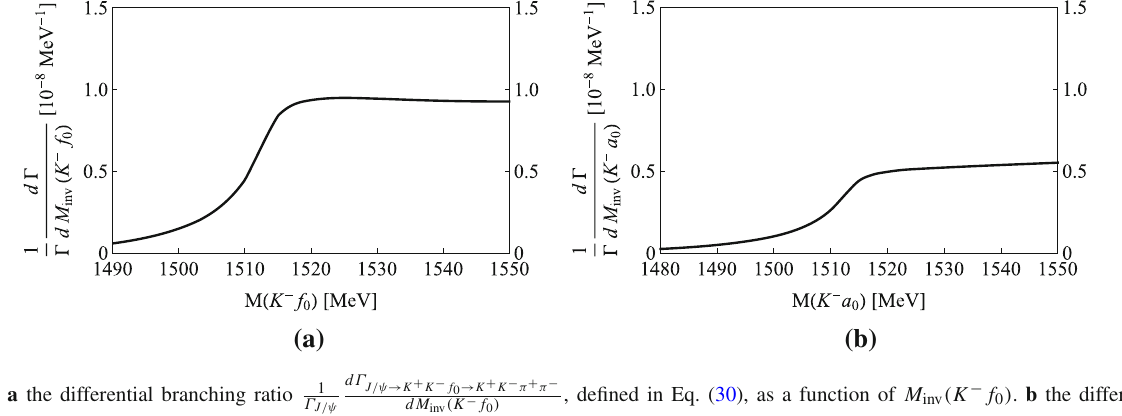
d Γ J /ψ → K + K − f + K − π + π − Fig. 8 a the differential branching ratio 1 Γ 0 → K , defined in Eq. (30), as a function of M inv ( K − f 0 ) . b the differential dM inv ( K − f 0 ) J /ψ d Γ J /ψ → K + K − a + K − π 0 η 0 → K , defined in Eq. (31), as a function of M inv ( K − a 0 branching ratio 1 Γ dM inv ( K − a 0 ) J /ψ